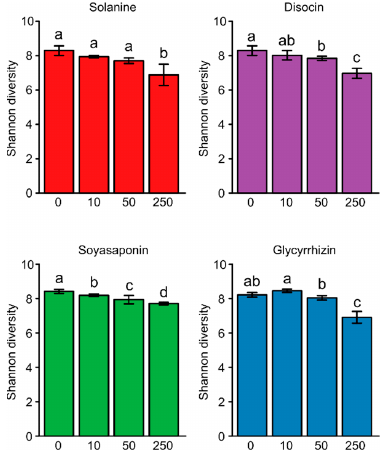
Figure 2. Shannon diversity indices of the bacterial communities in the soils treated with saponins, 10, 50, and 250 nmol (low, middle, and high concentrations) g soil − 1 . Error bars indicate standard deviation ( n = 4). Different letters (a–d) indicate statistically significant differences ( p < 0.05) by Welch ʼ s t ‐ test, corrected by the Benjamini–Hochberg method. Each saponin ‐ 0 indicates untreated soils.